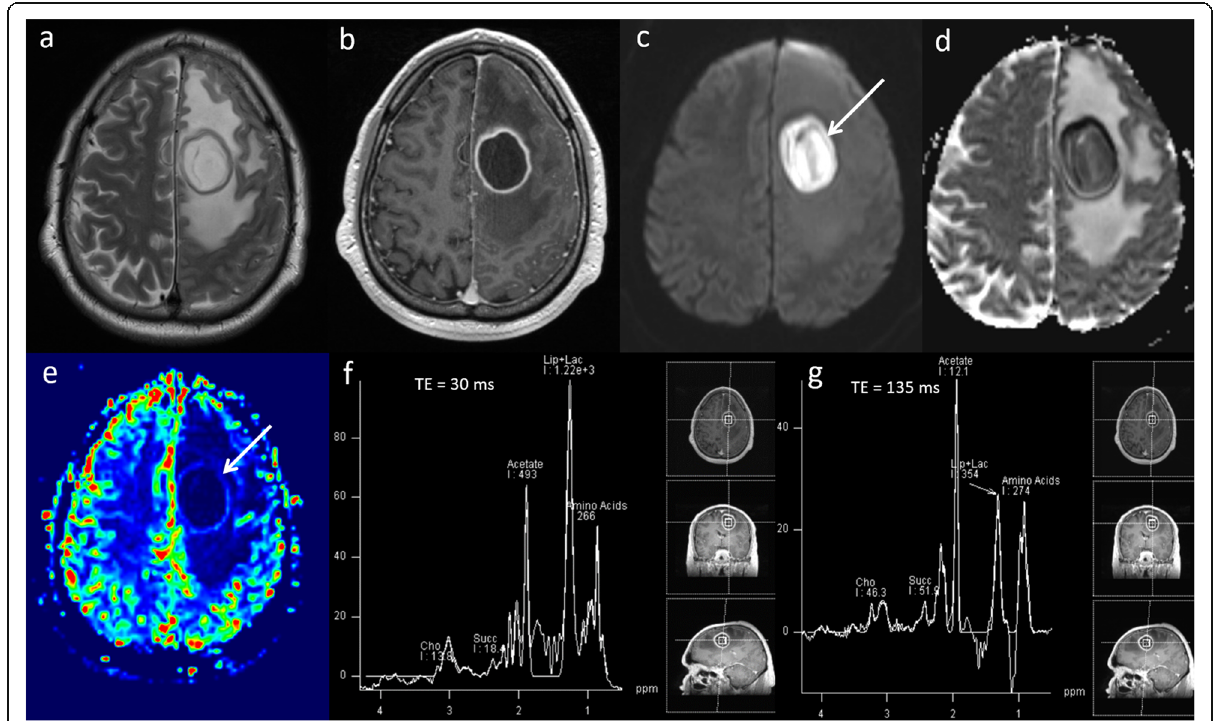
Fig. 12 Abscess. Conventional MRI: a , b T2W and post-contrast T1W sequences demonstrate a ring-enhancing mass lesion in the left frontal lobe with surrounding oedema. c , d DWI and ADC sequences show low ADC (600 × 10 − 6 mm 2 s − 1 , arrow) throughout the lesion. e PWI demonstrates significantly lower perfusion (arrow) than the contralateral white matter. f , g MRS shows high lipid as well as the presence of amino acid (0.9 – 1.0 ppm), acetate (1.92 ppm) and succinate peaks (2.42 ppm). These characteristic MRS findings in combination with the very low ADC and low perfusion are diagnostic of abscess. Diagnosis was confirmed on aspiration which revealed colonies of gram-positive